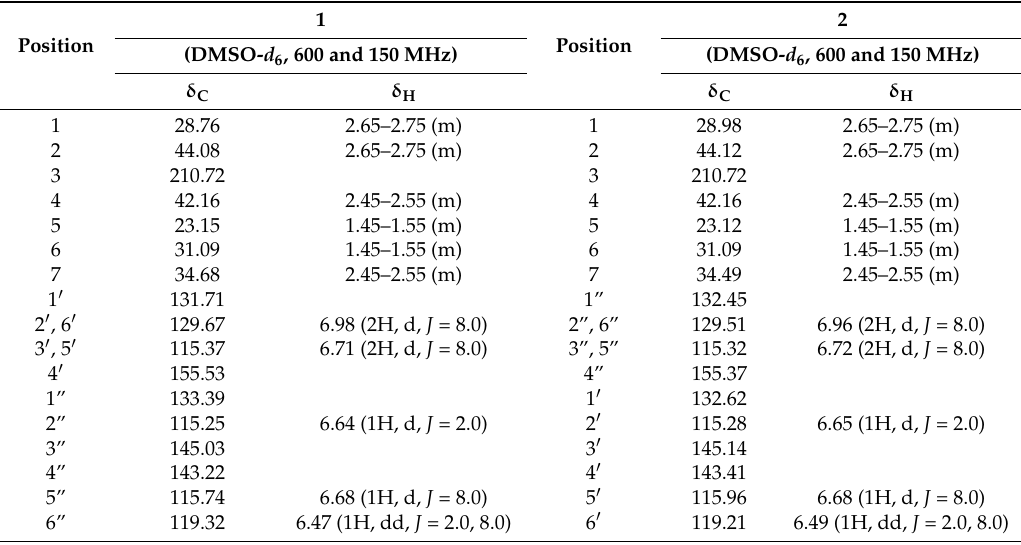
Table 1. 13 C and 1 H-NMR data of compounds 1 and 2 .